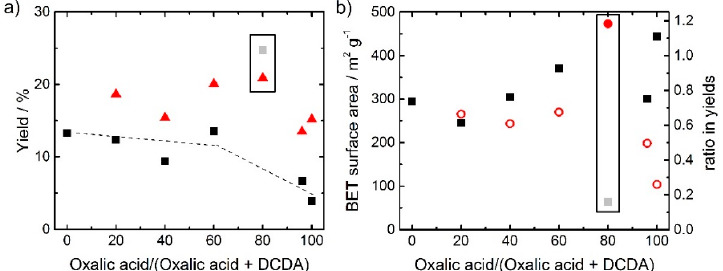
Figure 1. ( a ) Change of the synthesis yield as a function of relative part of oxalic acid in the overall SFA (considering molar fractions), both the yield after heat-treatment ( ▲ ) and after heat-treatment plus acid-leaching ( ■ ) are shown. In ( b ) the relation between BET surface area (left axis, ■ ); respectively, ratio of the yields (right axis, o ) and the amount of oxalic acid in the structure-forming agent (SFA) are given.